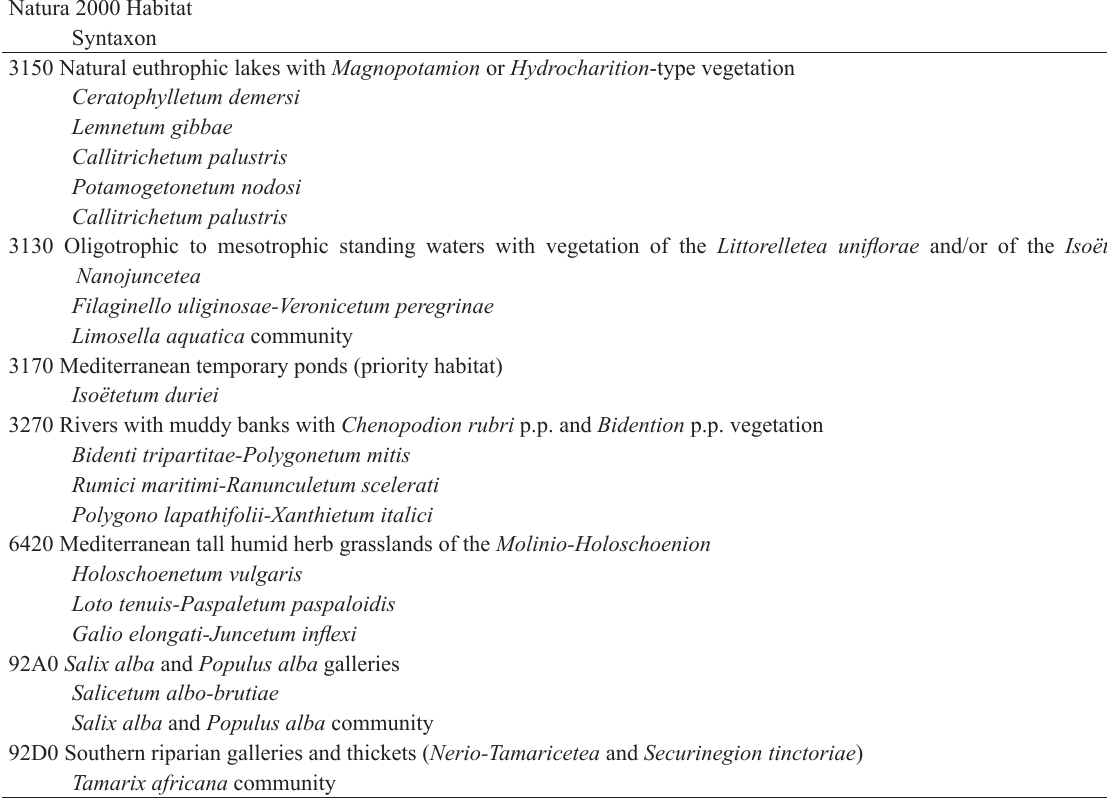
Table 8. Habitats of Community Interest according to European Directive 92/43/EEC. Natura 2000